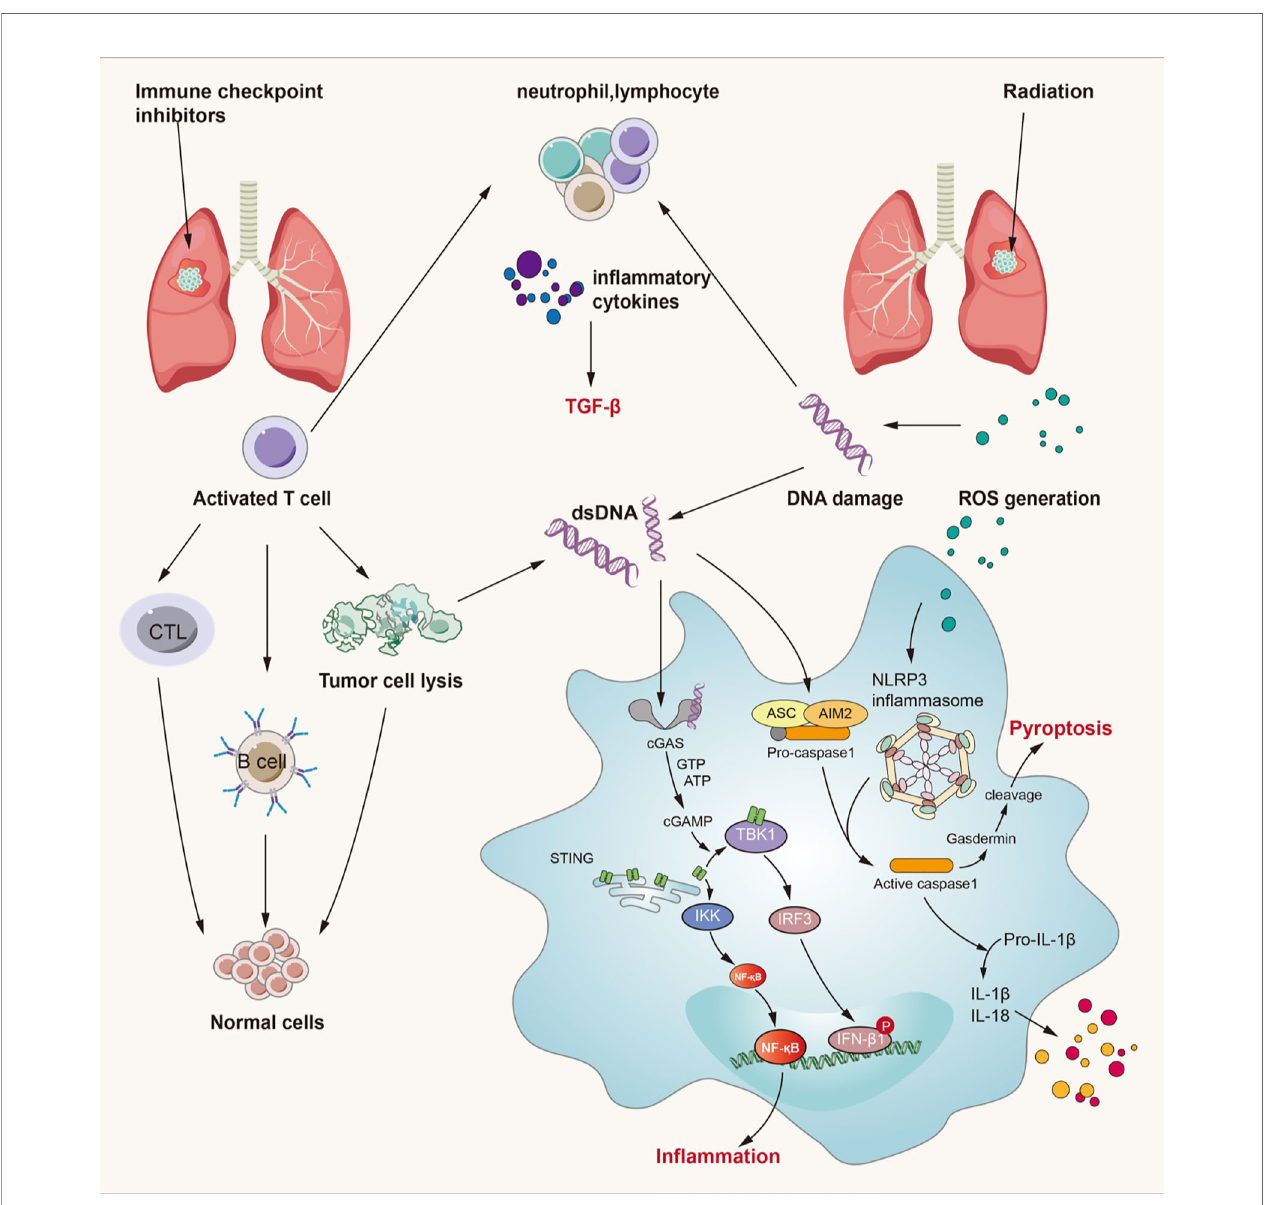
FIGURE 3 | Crossed pathways for radiation-induced and immunotherapy-related lung injury. Radiation and checkpoint inhibitor therapy can induce immune cells activation. Activated cells can release many kinds of in fl ammatory factors like IL-3, IL-4, IL-10, IL-17, TNF- a , TGF- b and so on. Thereinto, TGF- b /Smad and cGAS- STING pathways play an important role in both RILI and IRLI. Except the classical function of TGF- b , it also exerts synergistic effects with PD-L1 in maintaining self-antigens tolerance and promoting Treg development. cGAS-STING signaling can recognize cytosolic DNA damaged by irradiation and CTL and then lead to pulmonary in fl ammation and fi brosis. ROS can lead to activation of NLRP3 in fl ammasome complex resulting in caspase-1 activation. Activated caspase-1 can induce IL-1 b and IL-18 maturation which can lead to in fl ammation. At the same time, caspase-1 can cause gasdermin cleavage which can immediate